Question: Which visualization type does this figure use?
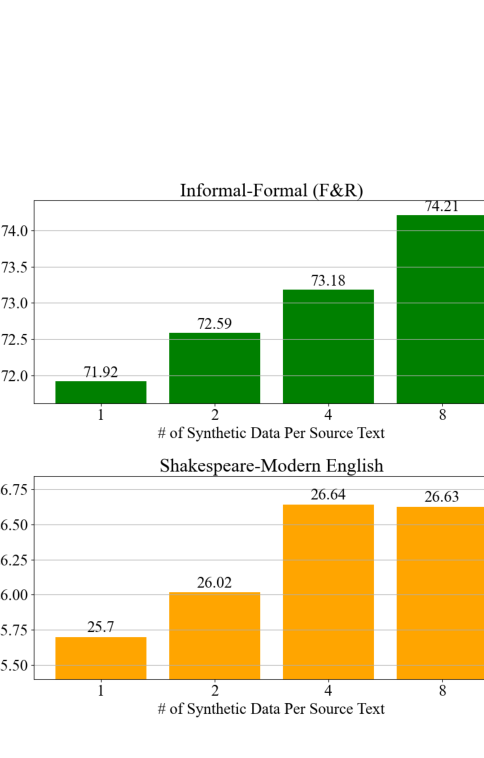
Answer: line